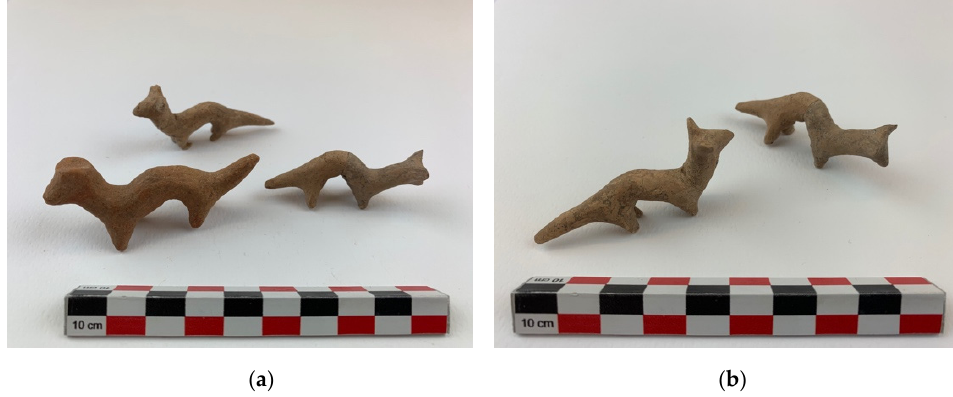
Figure 3. ( a , b ) Clay models of weasels. Petsophas. Crete, c. 2000–1600 BCE. Archaeological Museum of Agios Nikolaos, Crete.